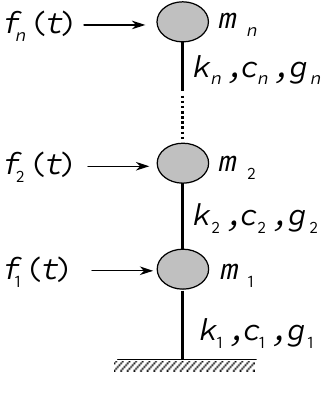
Fig. 1. Shear type MDOF Duffing